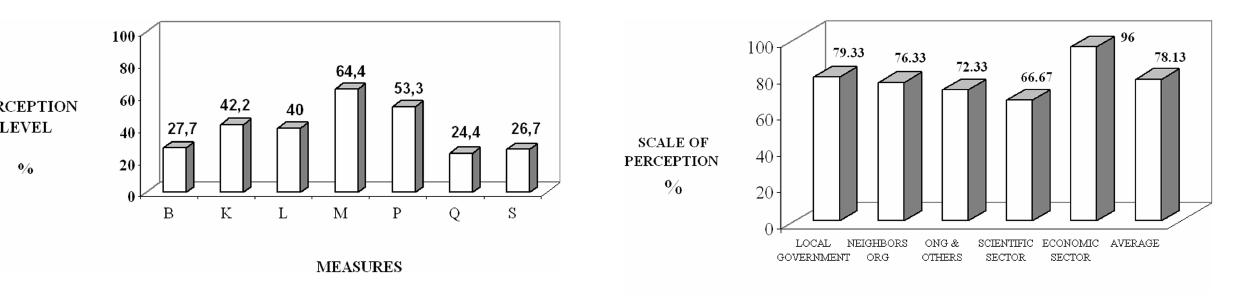
Fig. 13. Preferences for flood management measures. Social sectors in focus group sessions.